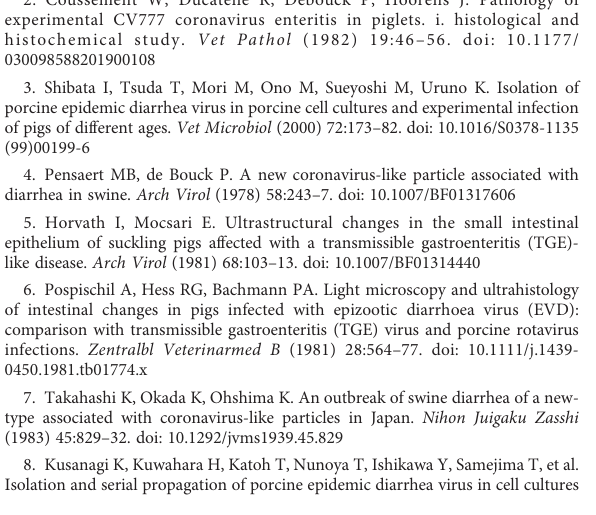
SUPPLEMENTARY FIGURE 1 The comparison of the dysregulated proteins in FJzz1-infected LLC-PK1 cells. LLC-PK1 cells were mock-infected or infected with FJzz1 at an MOI of 0.01 for 18 h, and all cells were collected to perform the TMT labeled comparative proteomic analysis. The heatmap shows the relative expression level of the dysregulated proteins in both Mock- and FJzz1- infected LLC-PK1 cells (Log 2 fold-change). SUPPLEMENTARY FIGURE 2 FJzz1 infection induced the production of ISGs in LLC-PK1 cells in a dose- dependent manner. LLC-PK1 cells were infected with different MOI (0.01, 0.1, 0.5) of FJzz1 for 18 h, and total cellular RNA was extracted to determine the mRNAlevelofRSAD2 (A) ,OAS1 (B) ,Mx1 (C) ,Mx2 (D) ,IFIT1 (E) ,andISG15 (F) by RT-qPCR. These data are representative of the results of three independent experiments, and error bars represent standard deviations. Asterisks indicate statistical signi fi cance. ***, P < 0.001. SUPPLEMENTARY FIGURE 3 SiRNA interference. LLC-PK1 cells were transfected with 80 nM speci fi c siRNA targeting RIG-I, MDA5, MAVS, MyD88, TRIF, or an NC siRNA for 24 h, and then cellular RNA was extracted for analysis of RIG-I (A) , MDA5 (B) , MAVS (C) , MyD88 (D) , and TRIF (E) mRNA levels by RT-qPCR. These data are representative of the results of three independent experiments, and error bars represent standard deviations. Asterisks indicate statistical signi fi cance. ***, P < 0.001.